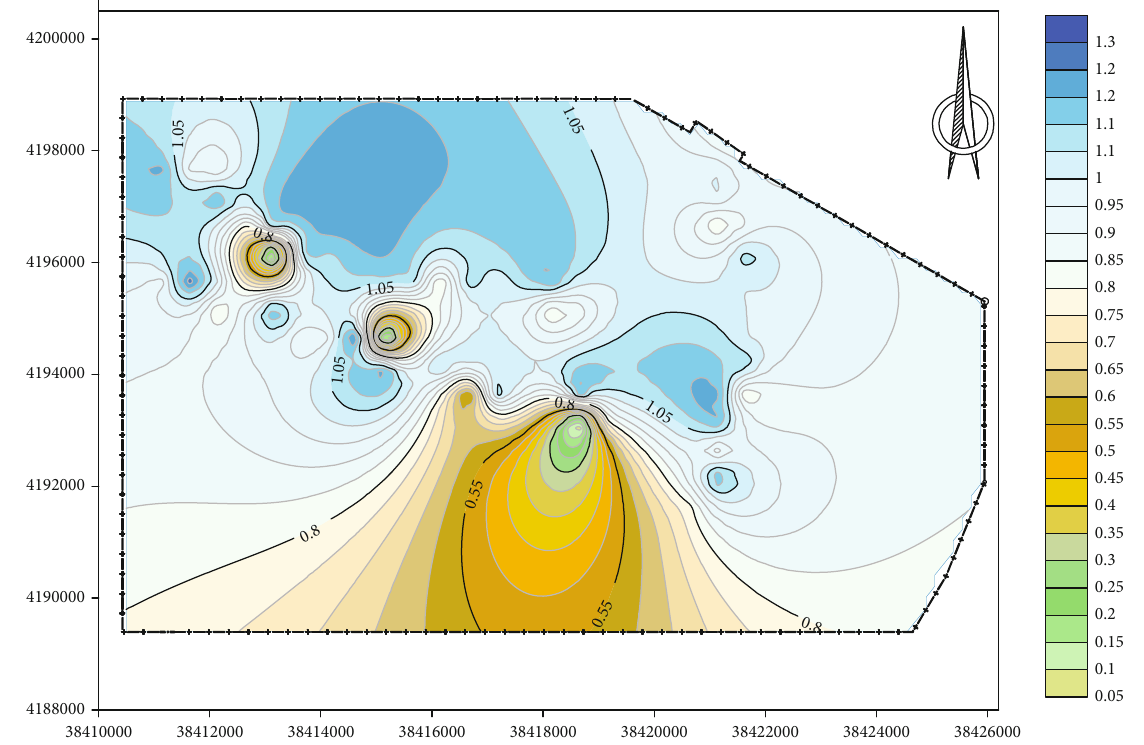
Figure 8: Thematic map of the fold fractal dimension